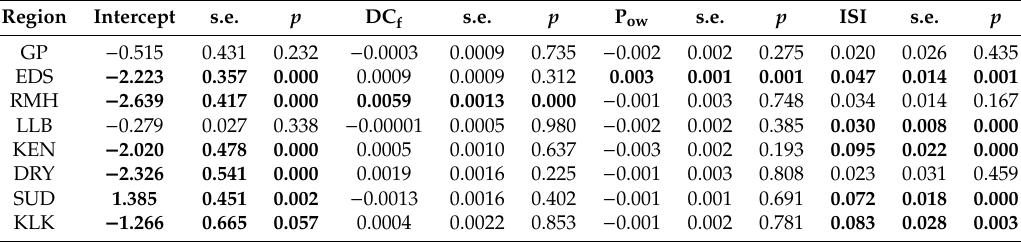
Table 3. Logistic regression coe ffi cients along with corresponding standard errors (s.e.) and p-values (p), for the probability of a spring fire escaping initial attack and growing to over 4 ha. Explanatory variables tested include the DC value at the end of the previous season fall (DC f ), overwinter precipitation (P ow ), and Initial Spread Index (ISI). Results for coe ffi cients with very high to moderate evidence (0 < p < 0.10) appear in